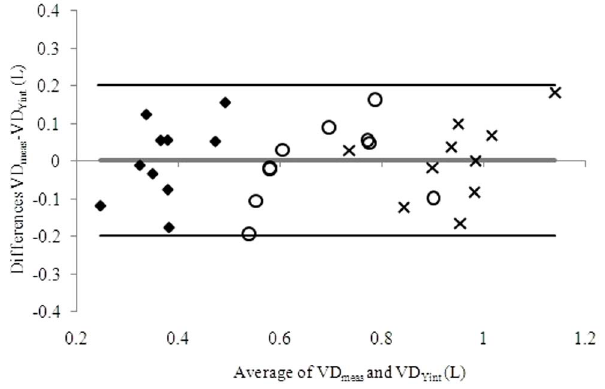
Figure 5. Bland and Altman plot of estimated dead space (DS) volume calculated as VE Yint /RR Yint (VD Yint ) and measured DS volume (VD meas ) at rest, calculated as (1–863/P a CO 2 (VE/ VCO 2 )*VT) with P a CO 2 for healthy subjects with 0 mL (dia- monds), 250 mL (circles) and 500 mL (crosses) of additional DS. The grey line identifies the mean difference of VD meas - VD Yint; the black lines identify the mean difference of VD meas - and VD Yint 6 1.96*- standard deviation. P a CO 2 was estimated from P ET CO 2 . P a CO 2 =carbon dioxide pressure; P ET CO 2 = tele-expiratory carbon dioxide pressure; VE=ventilation; VT=tidal volume.